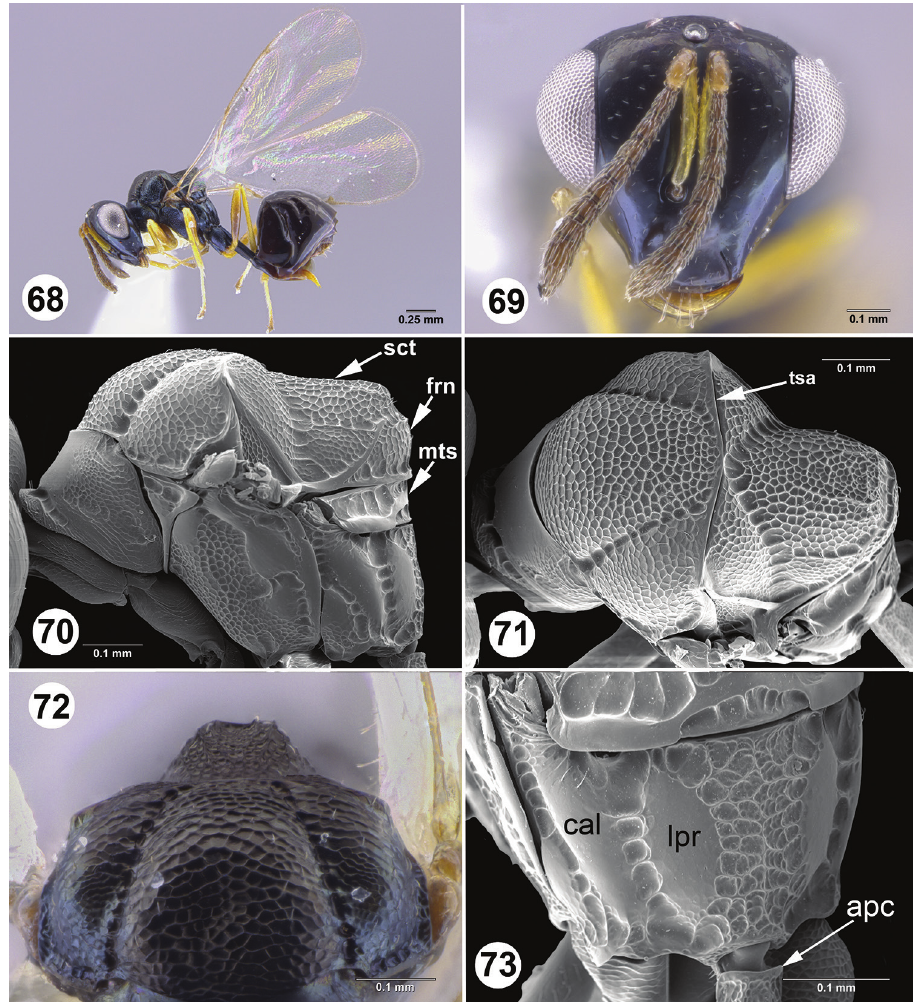
Figures 68–73. Zuparka fisheri . Paratype female: 68 habitus, lateral 69 head, anterior 70 mesosoma, lateral 71 mesosoma, oblique dorsal 72 mesosoma, anterior 73 propodeum, oblique dorsal. apc = anterior petiolar carina; cal = callus; frn = frenum; lpr; lateral propodeal disc; mts = metascutellum; sct = mesoscu- tellum; tsa = transscutal